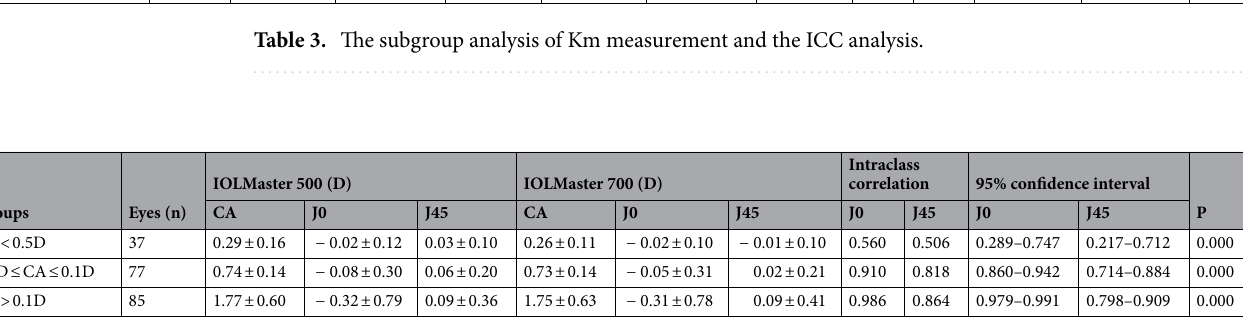
Table 4. The subgroup analysis of CA measurement and the ICC analysis.